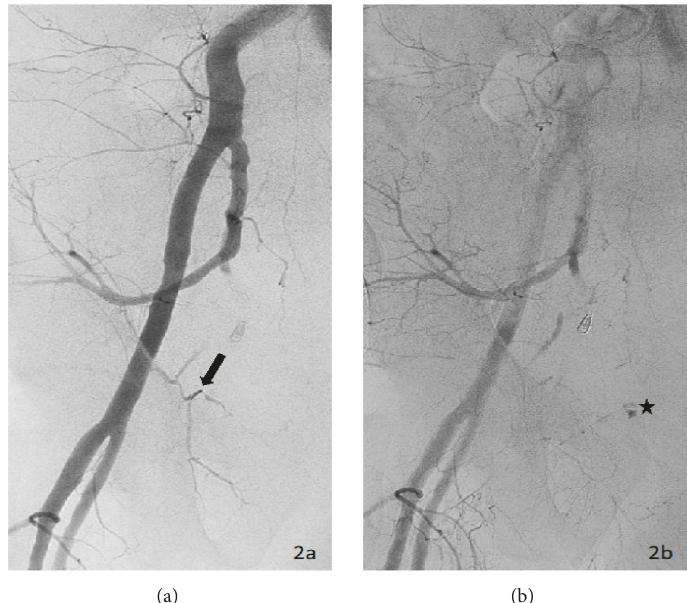
Figure 2: Right external iliac arteriogram. (a) The early phase demonstrates a right corona mortis (arrow) originating from the inferior epigastric artery. (b) Delayed imaging reveals active extravasation from the corona mortis